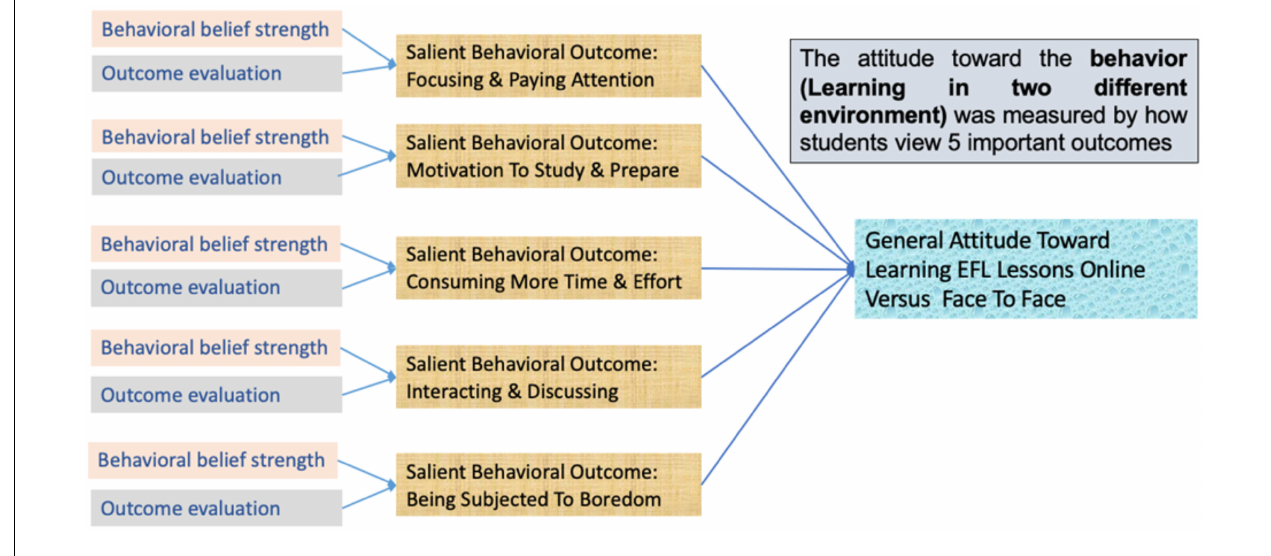
FIGURE 1 | An illustrative example from this